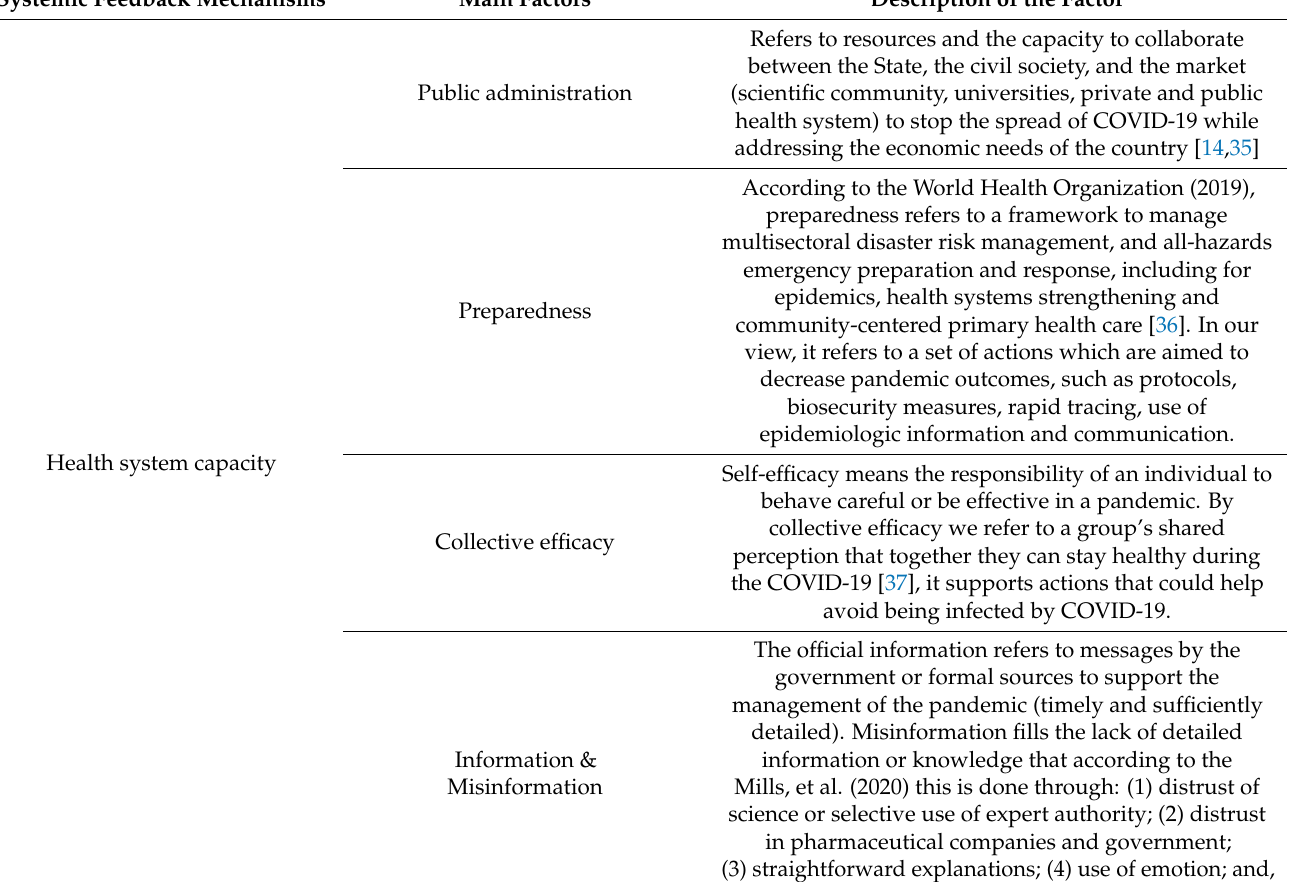
Table 1. Main factors to categorize codes relevant to the health system capacity. Systemic Feedback Mechanisms Main